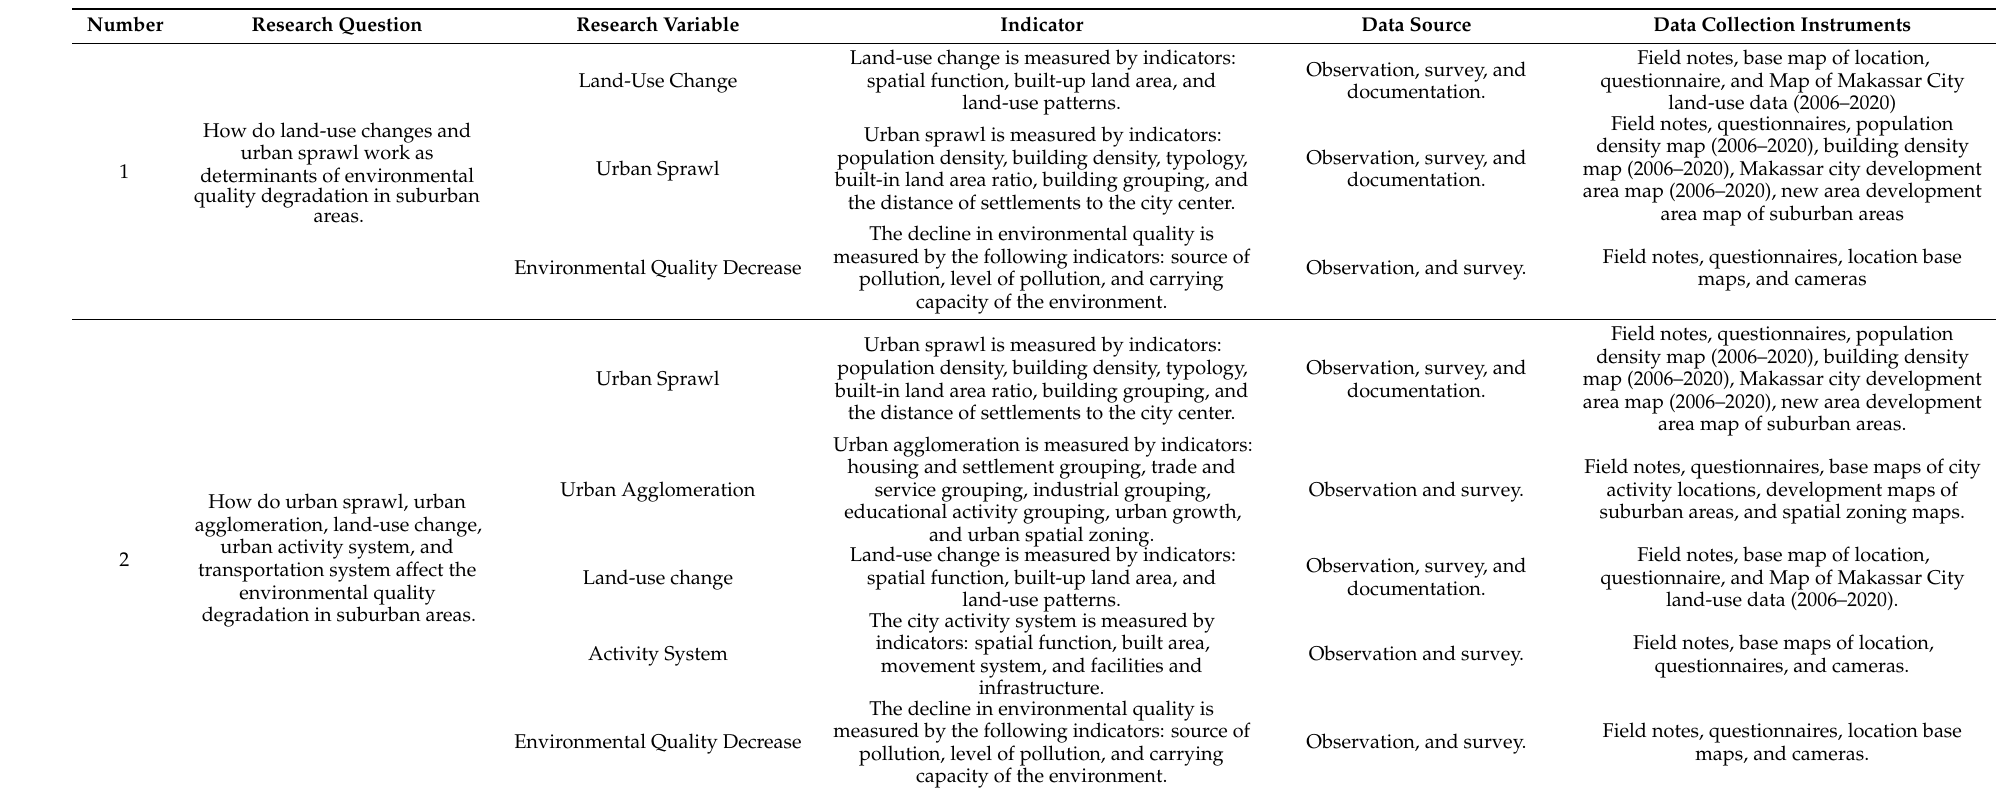
Table 2. Summary of research data and data collection